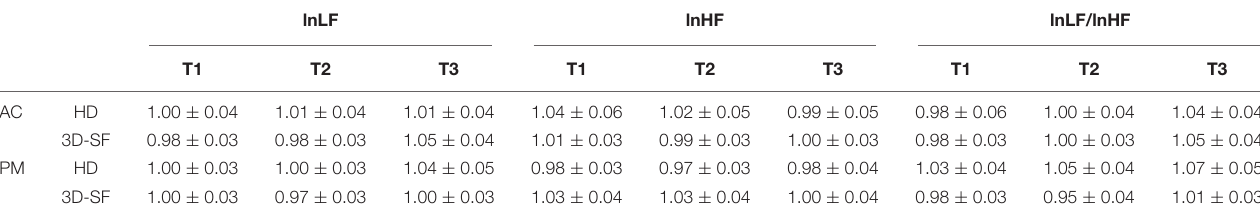
TABLE 2 | Summary of heart rate variability